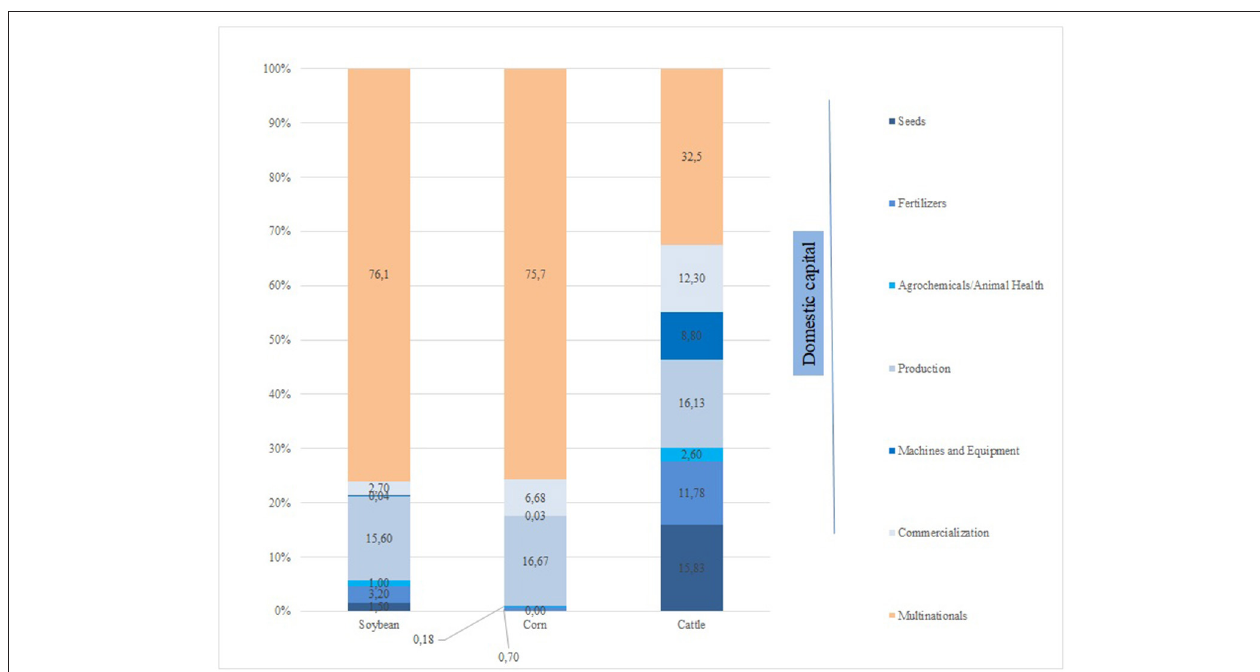
FIGURE 5 | Participation of domestic capital in the soybean, corn and cattle production chains in Brazil in 2019. Source: Prepared by the authors based on the weighted sum of the participations of domestic groups in the six segments analyzed according to Table 1